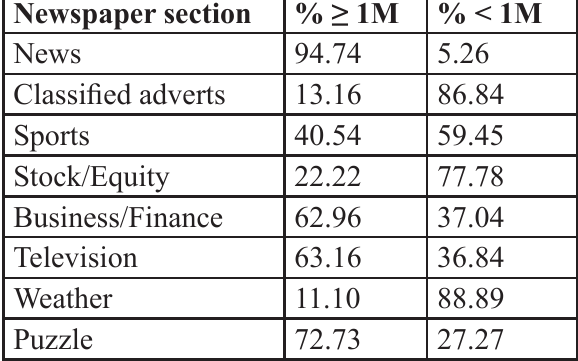
Table 2: Percentages of print sizes in M units for the various sections of the newspapers that were greater or equal to 1M and those less than 1M. The news sections were mostly 1M in size, but only 22.22% of the stock and equity and 11.1% of the weather sections were printed in ≥ 1M